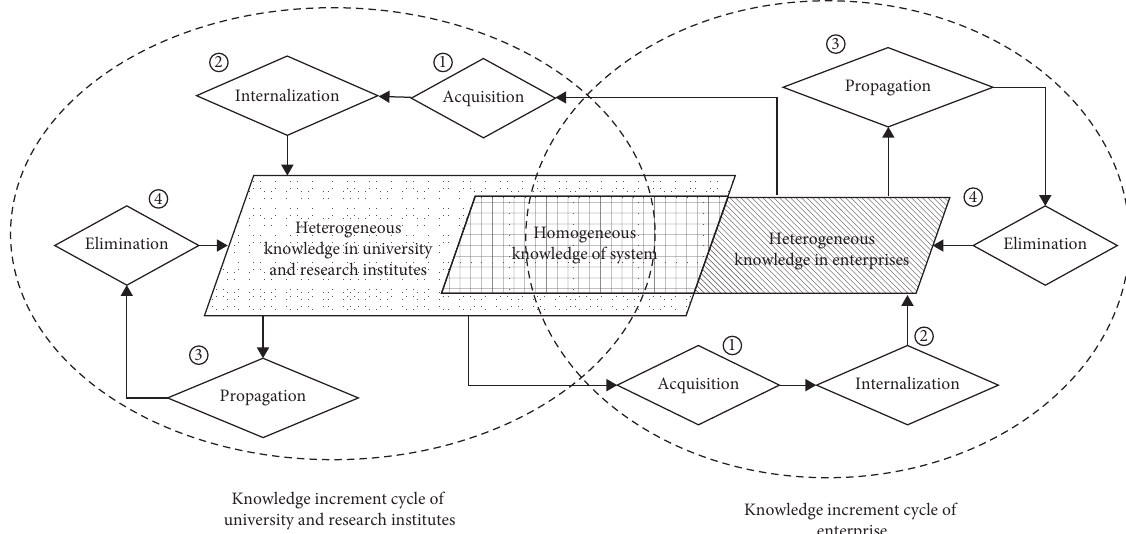
Figure 2: Double circulation of heterogeneous knowledge increment in